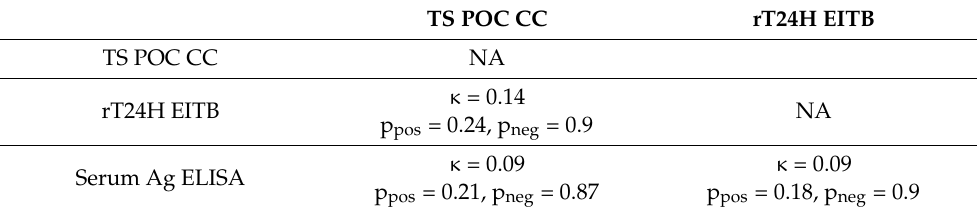
Table 4. Agreement between each of the different tests that were used for the detection of